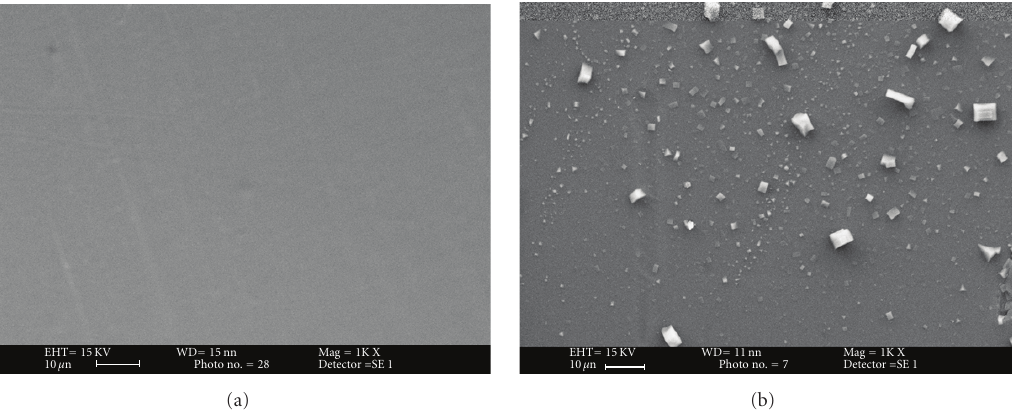
Figure 4: SEM images of (a) Acrylate matrix (without metal dispersion), (b) Acrylate matrix (with metal dispersion). The images confirm the presence of nanoparticles in the polymer